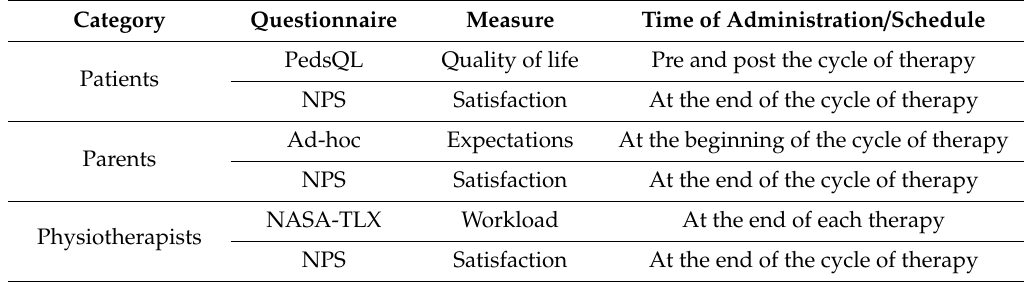
Table 3. Framework of ergonomic dimensions explored, questionnaires and time of administration.